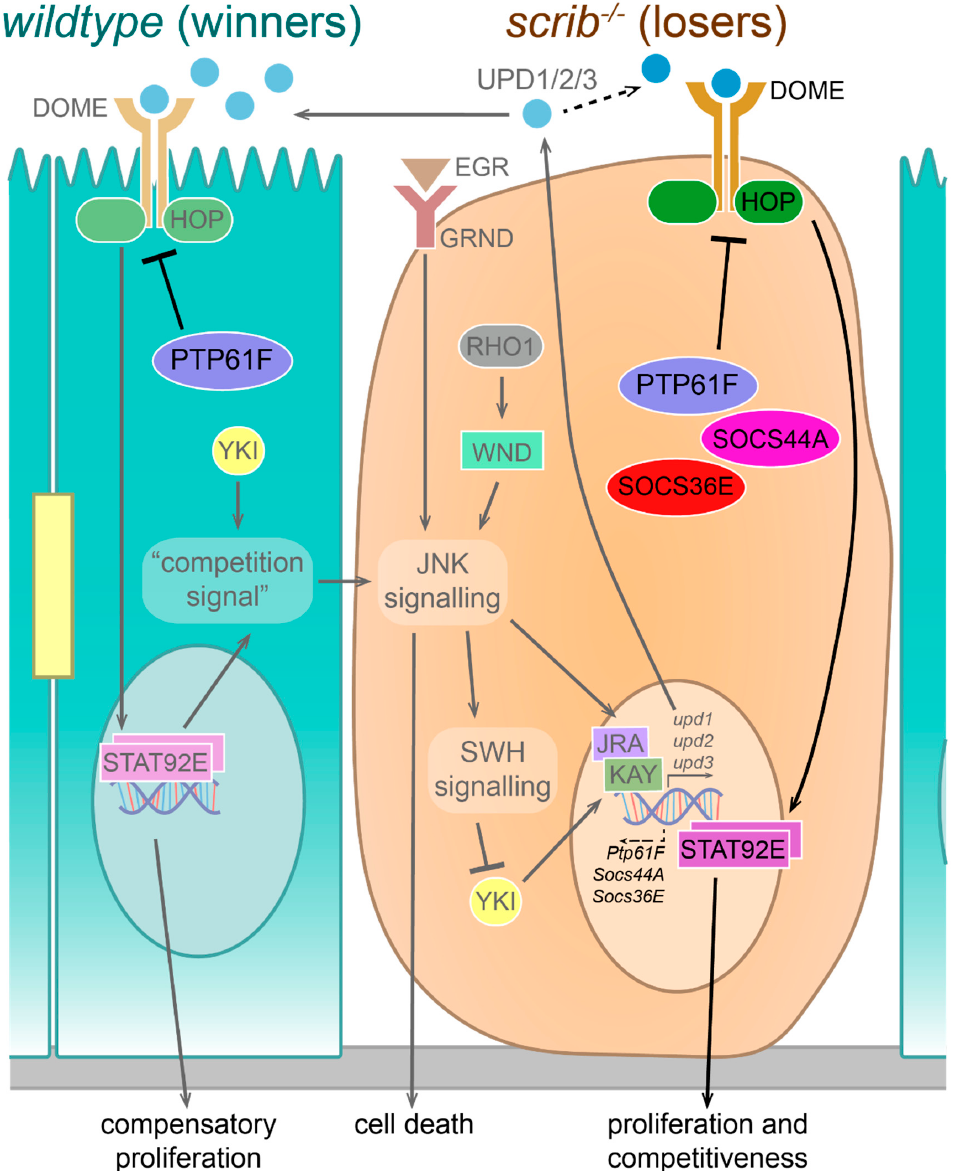
Figure 8. A model for PTP61F and JAK–STAT signalling during polarity-deficient cell competition. During polarity-defi-